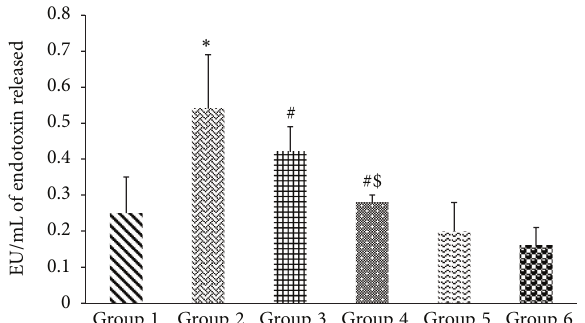
Figure 4: Effect of probiotic (free and encapsulated) on endotoxin levels in alcohol administered rats. Values are expressed as mean ± S.D. of eight different observations. ∗ 𝑃 < 0.05 versus group 1, group 5, and group 6; # 𝑃 < 0.005 versus alcohol (Alc) (group 2); $ 𝑃 < 0.05 versus group